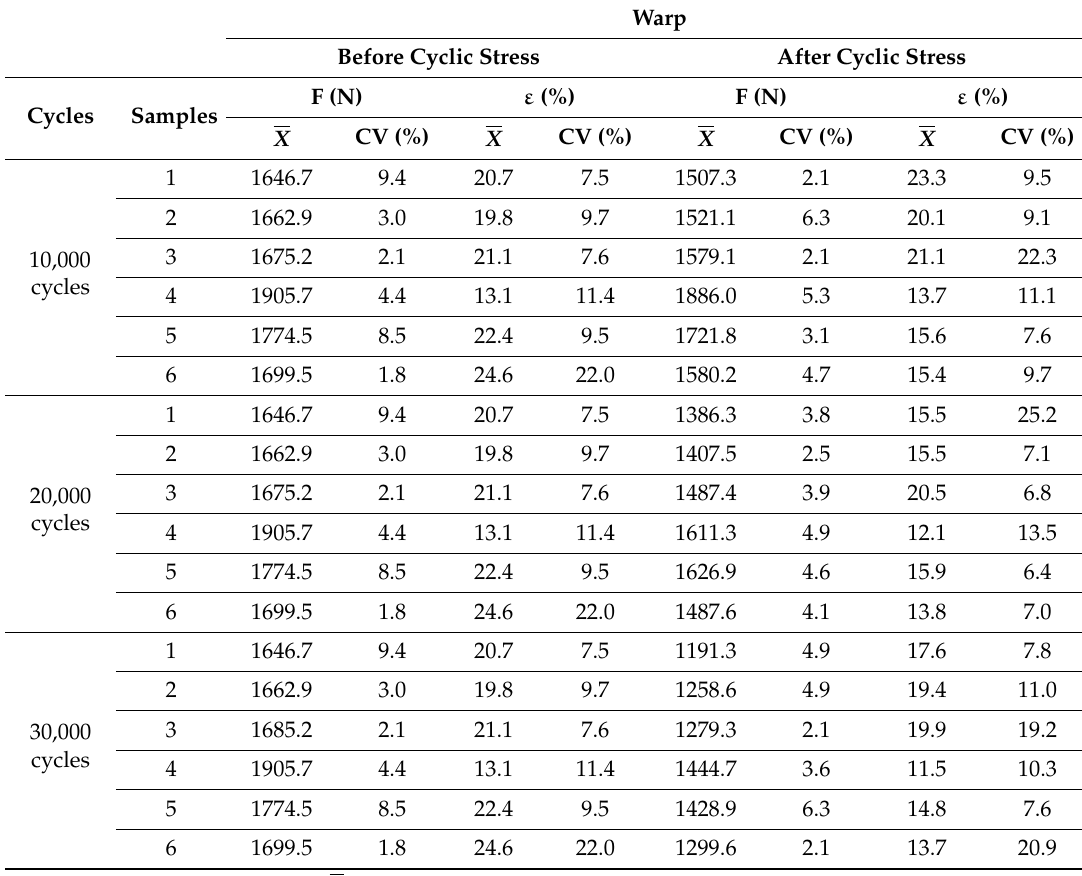
Table 3. Breaking force and elongation at break of samples in warp directions, before and after subjection to cyclic loads.